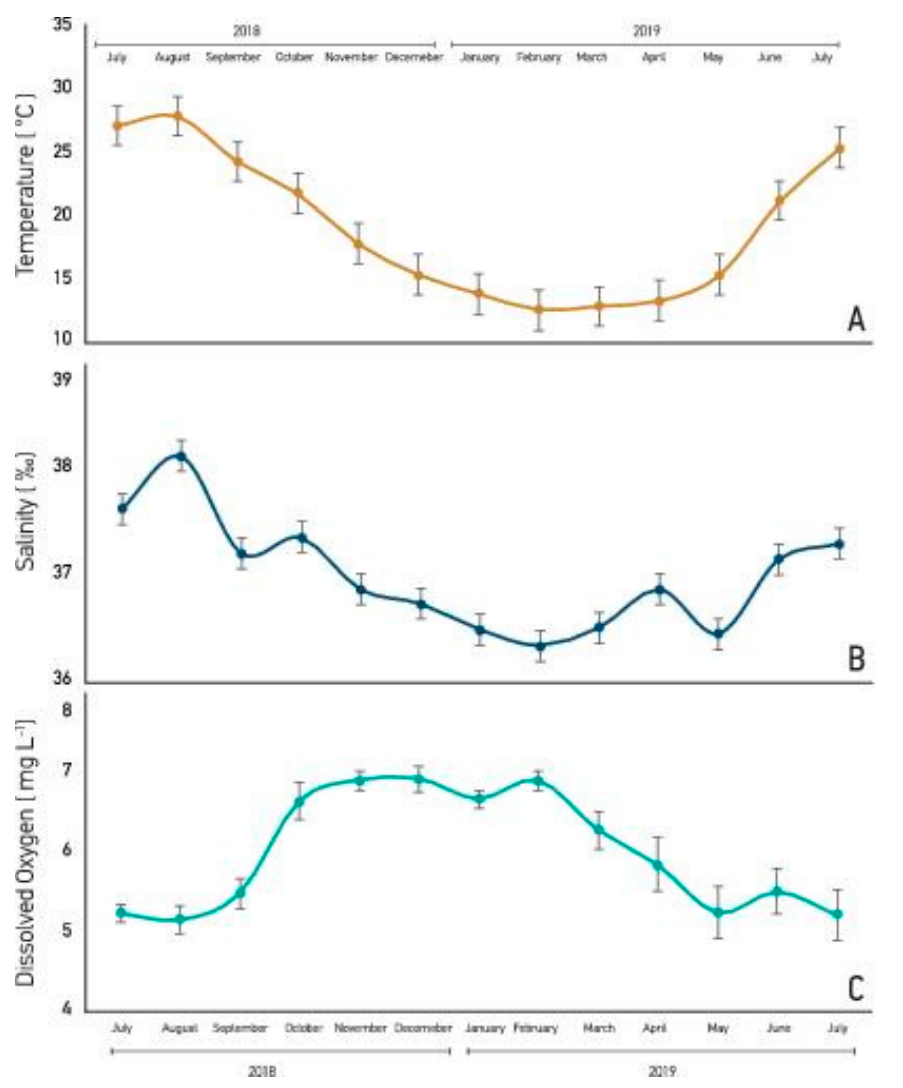
Figure 3. Temporal variation of abiotic parameters measured ( A ) temperature, ( B ) salinity and ( C ) dissolved oxygen, during the study period. Bars indicate standard deviation.